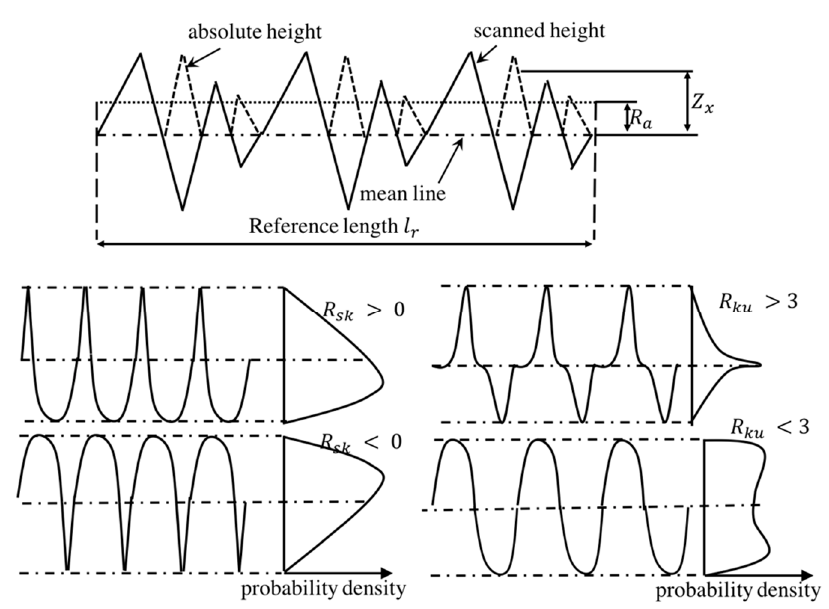
Figure 4. Description of roughness parameters.